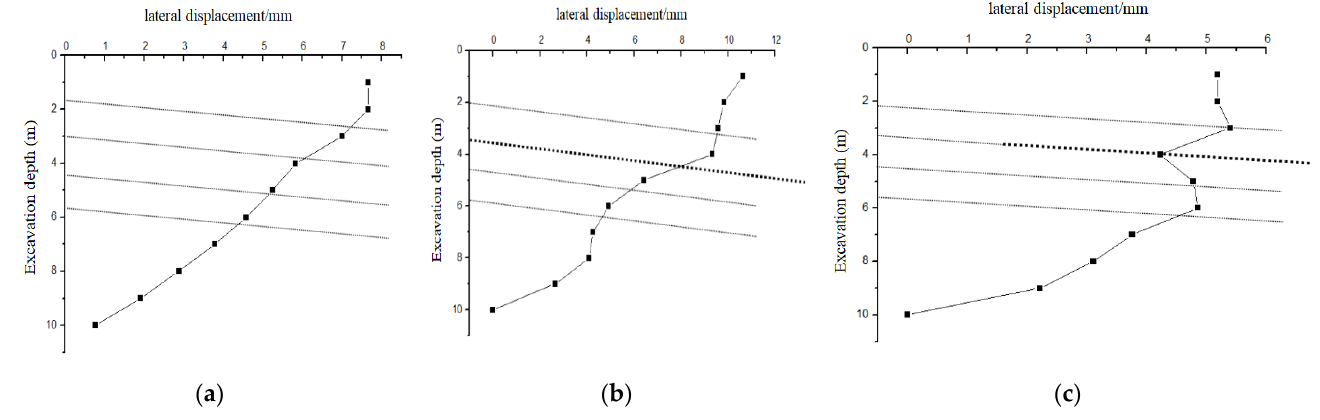
Figure 10. Distribution of lateral displacement along excavation depth. ( a ) Testing set No. 1 ( b ) Test- ing set No. 4 ( c )Testing set No. 5. ( b ) Testing set No. 4 ( c ) Testing set No.